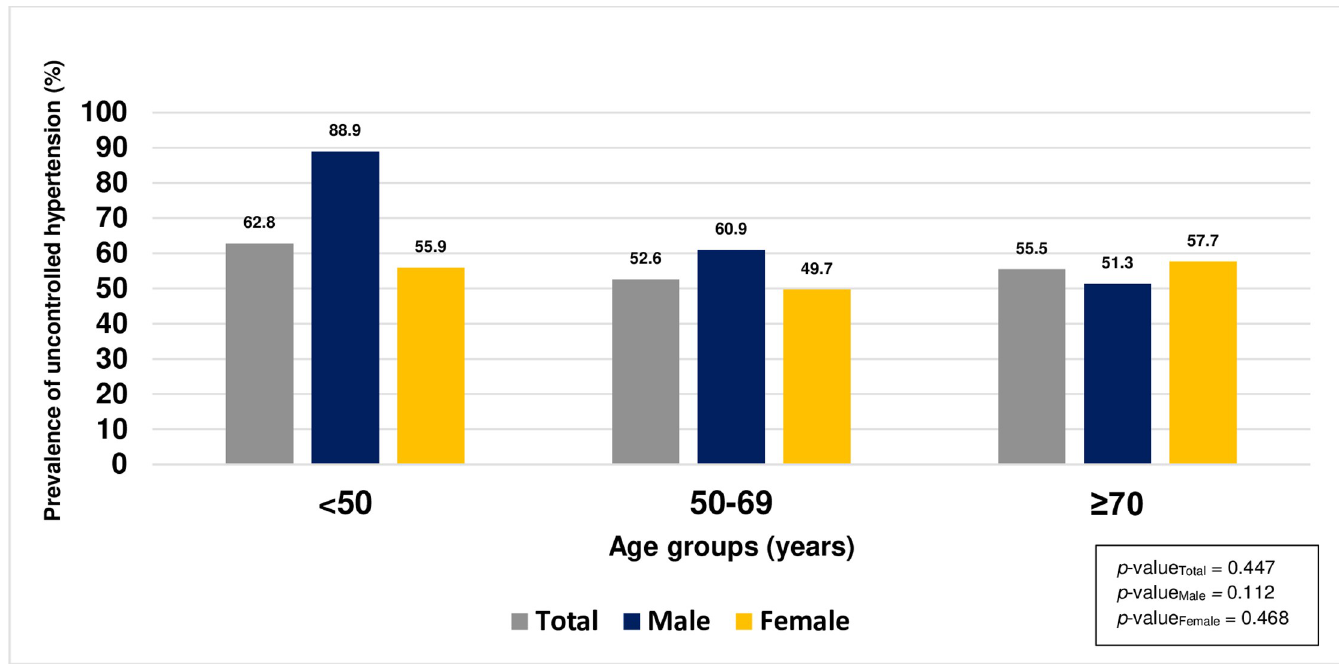
Fig 1. The prevalence of uncontrolled hypertension among adults with hypertension in the rural communities by age and gender.